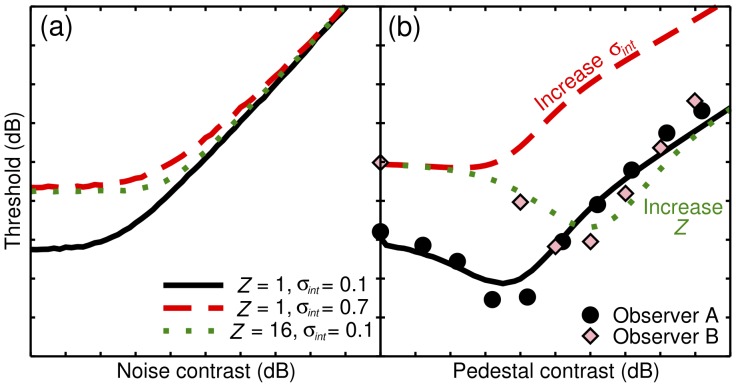
Behaviour of a nonlinear gain control model for noise masking (a) and contrast discrimination (b).The data in (b) are replotted from Henning & Wichmann [62] and are for observers NAL (circles) and GBH (diamonds). In both panels, green dotted curves show the effect of increasing the Z parameter of equation 1, and red dashed curves show the effect of increasing σint, relative to the solid curves.